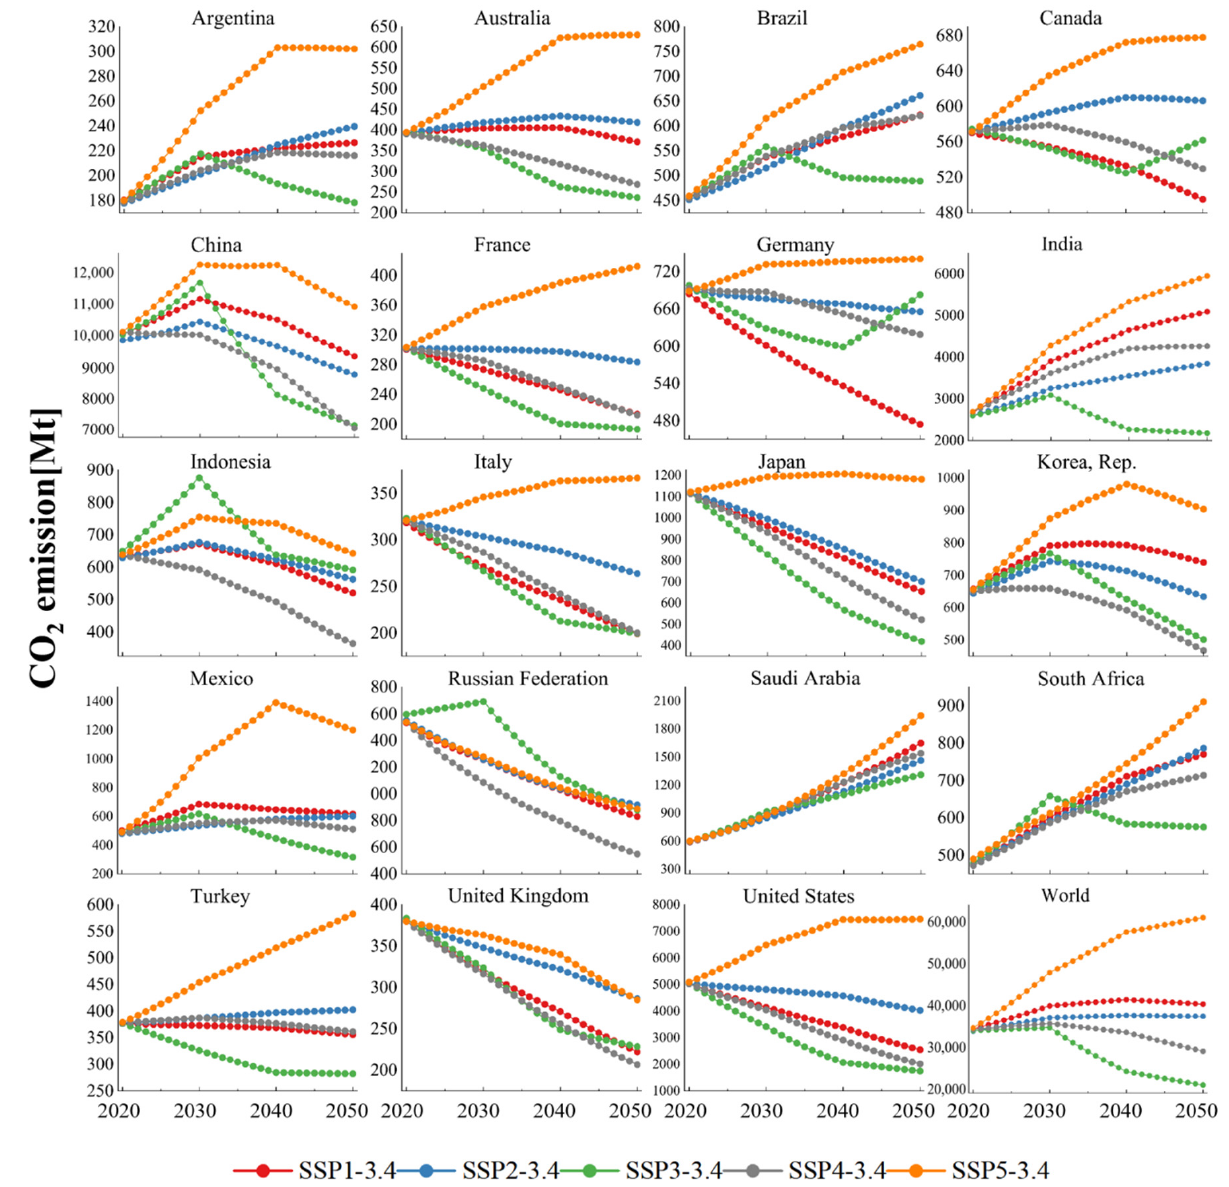
Figure 3. CO 2 emission paths during 2020–2050 in 3.4 W/m 2 scenarios of SSP.